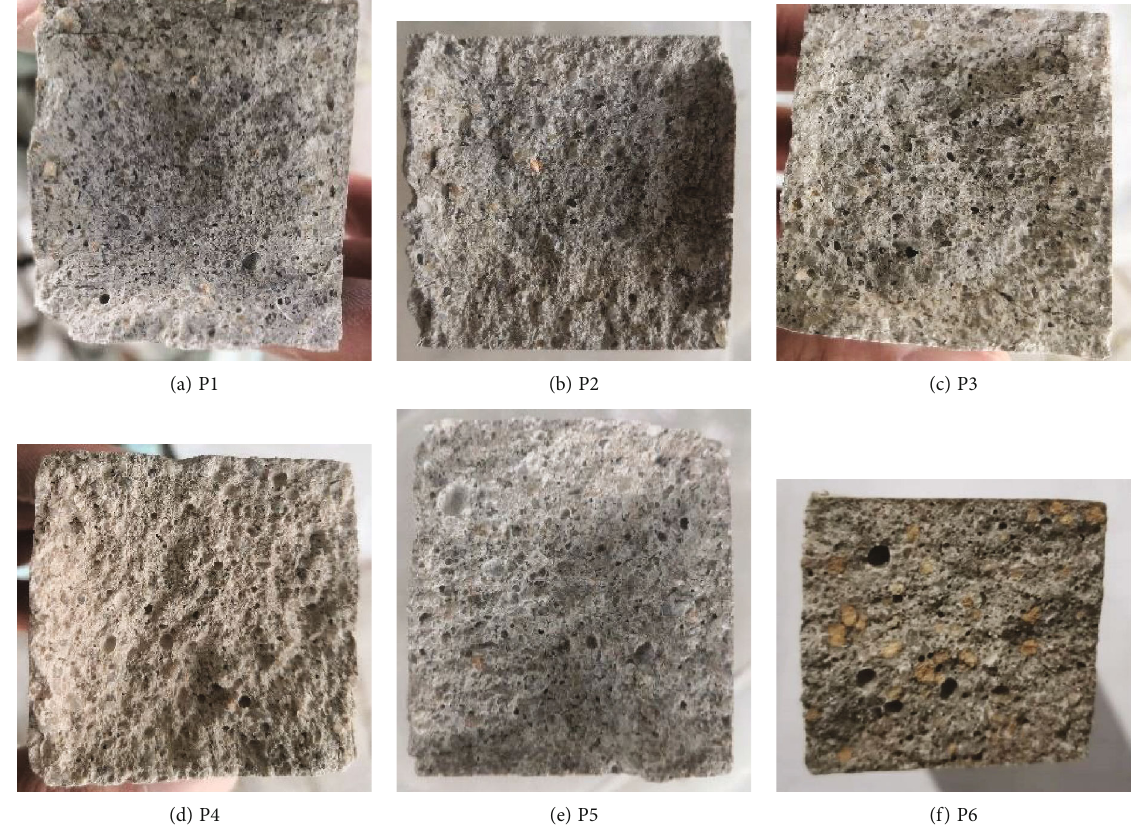
Figure 6: Damage section of test block fl exural